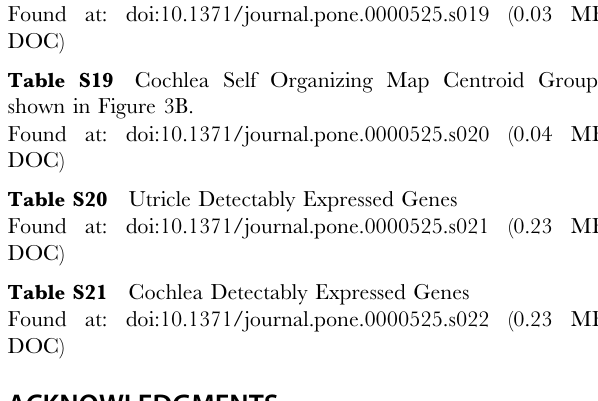
Table S13 WNT signaling. CN= Cochlea Neomycin time- course. CL= Cochlea Laser timecourse. UN =Utricle Neomycin timecourse. UL =Utricle Laser timecourse.